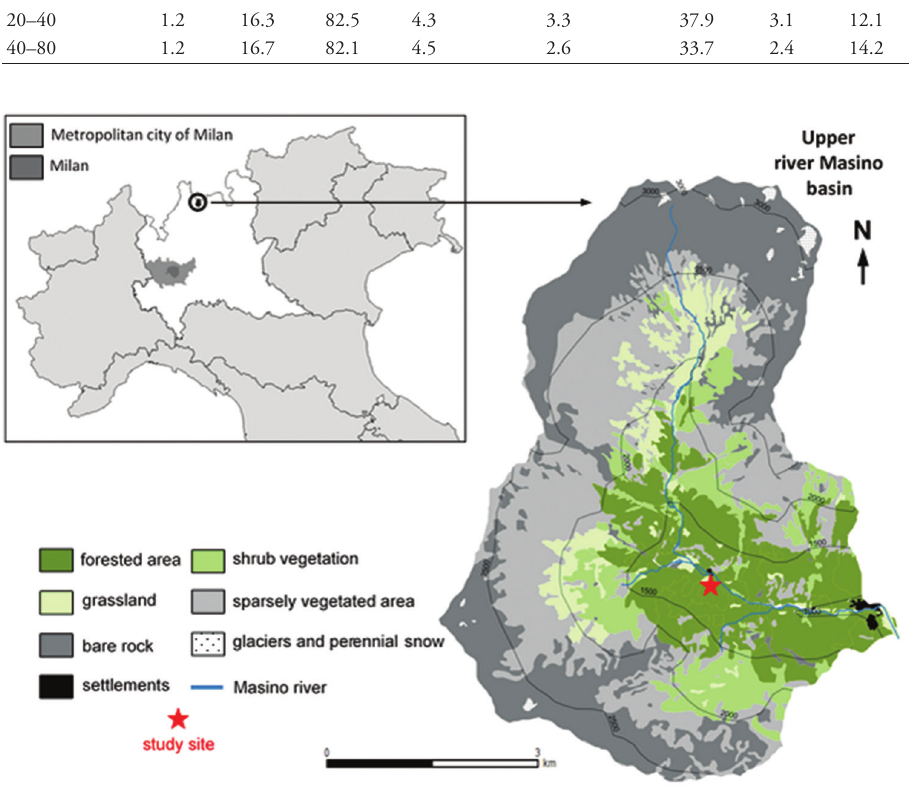
Figure 1. Location of the study site within the river Masino basin.